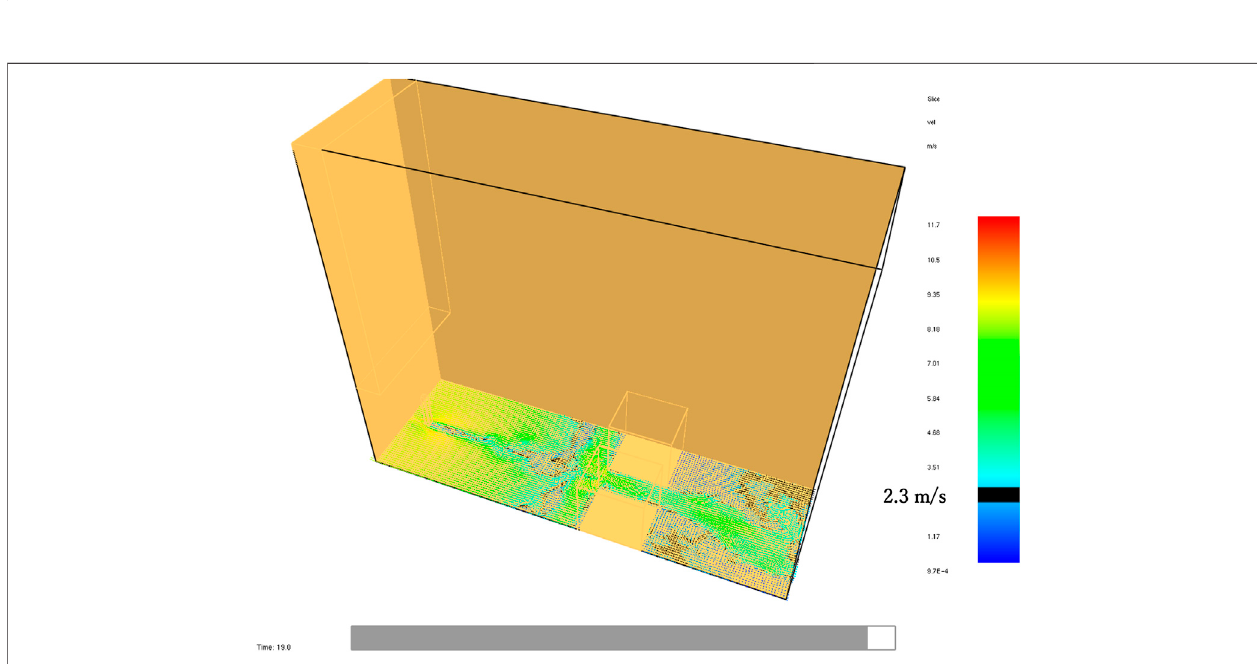
FIGURE 10 | FDS simulation results with 8 m s − 1 wind speed and SD (cid:2) 1 m. Wind pro fi le at ground level.